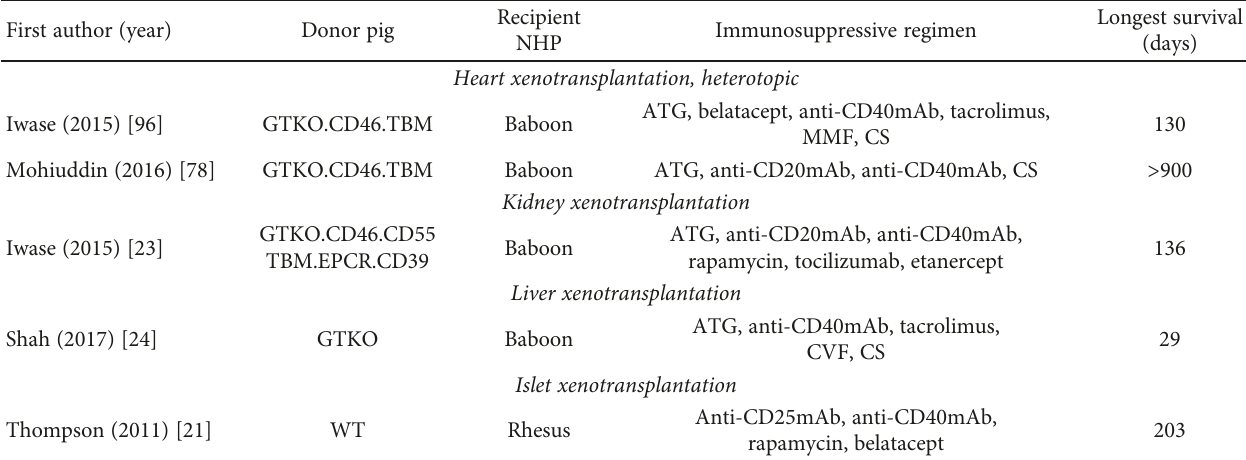
Table 3: Selected studies using anti-CD40mAb in pig-to-nonhuman primate